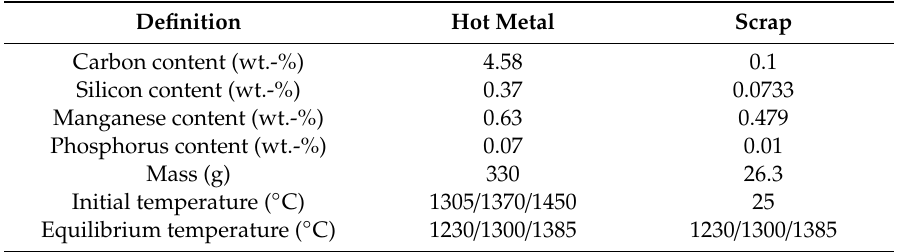
Table 1. Experimental data